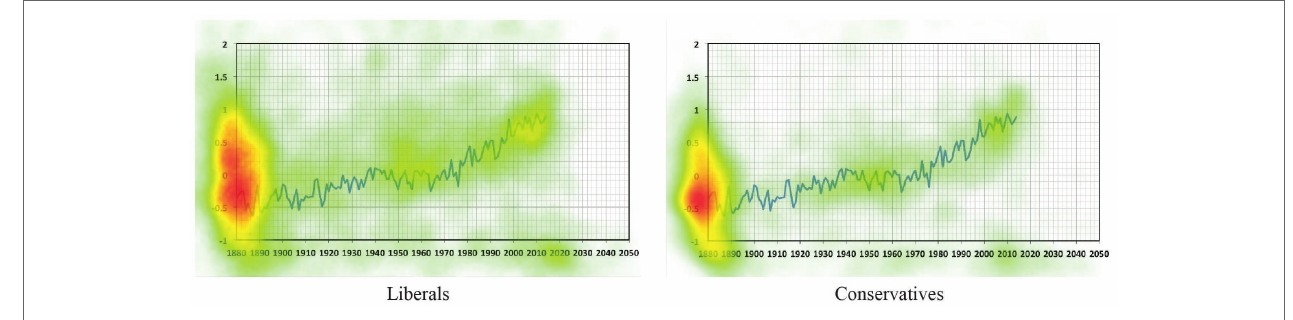
FIGURE 3 | A heatmap showing the average duration of dwell time on the temperature curve for liberals (left, N = 69) and conservatives (right, N = 21) in the temperature condition. Participants whose ratings on the political orientation scale were below 0 were grouped as liberals and whose ratings on the political orientation scale were above 0 were grouped as conservatives. Warmer colors represent higher average duration of dwell